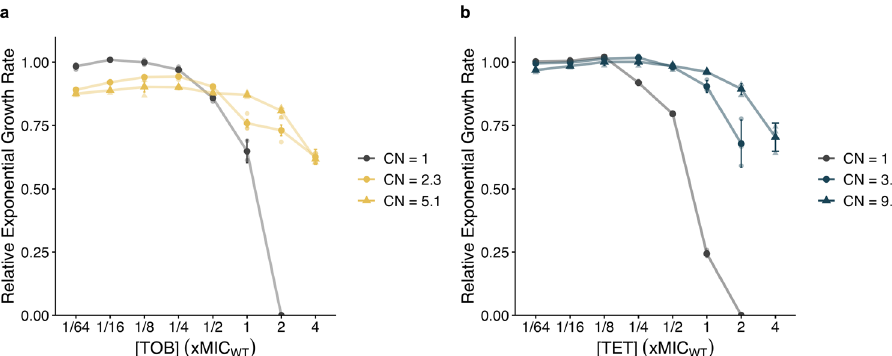
Fig. 3 Relative exponential growth rates as a function of increasing concentrations. Growth measured for independent clones selected in a tobramycin and b tetracycline for which copy numbers (CN) are 2.3 and 5.1 (in yellow circles and yellow triangles, respectively) and 3.5 and 9.4 (in blue circles and blue triangles), and the heteroresistant parental isolates with single copy ( E. coli DA33135 heteroresistant to tobramycin and S . Typhimurium DA34827 heteroresistant to tetracycline, represented in gray). The growth rates are relative to the growth of the heteroresistant parental isolate in the absence of antibiotic. The standard deviations of three biological replicates are reported ( n